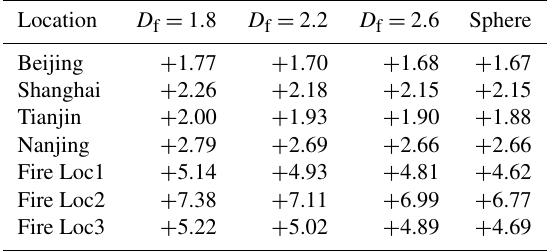
Table 2. Time-averaged BC all-sky ARI at different sites (Wm − 2